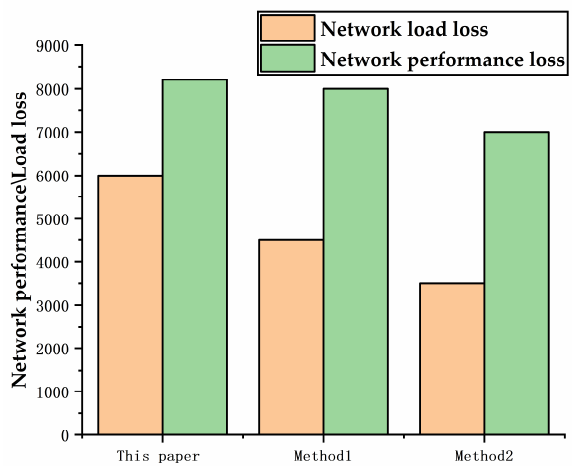
Figure 6. Comparison chart of network load loss and network efficiency loss after failure for each of the three methods.